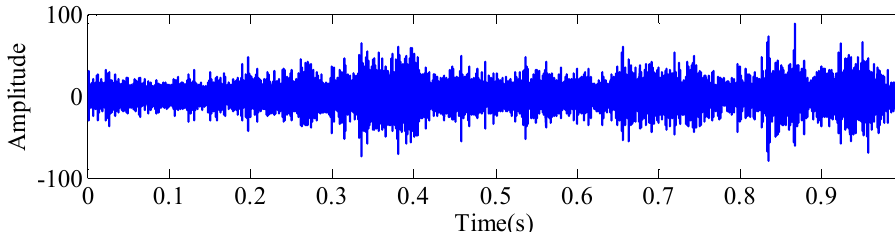
Figure 20. Time domain map of the randomly selected signal segment.